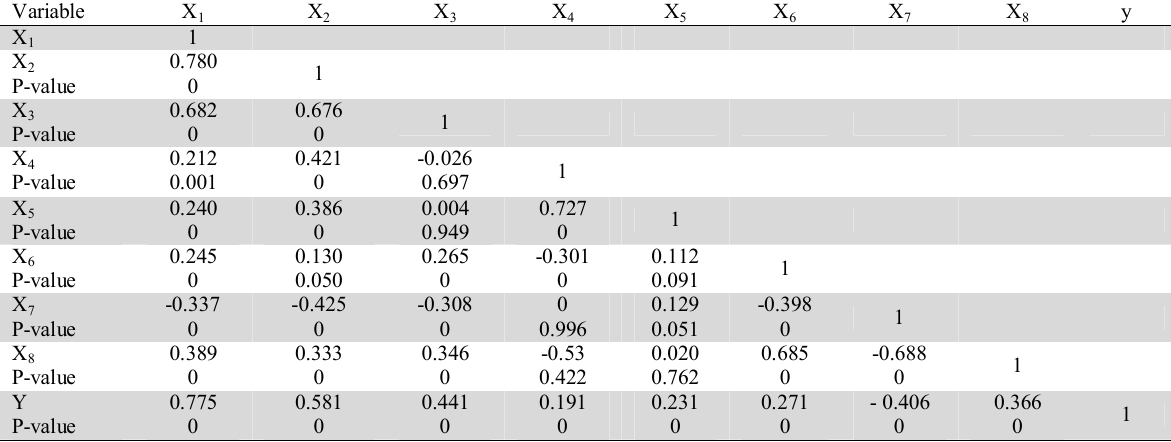
Non-parametric correlation